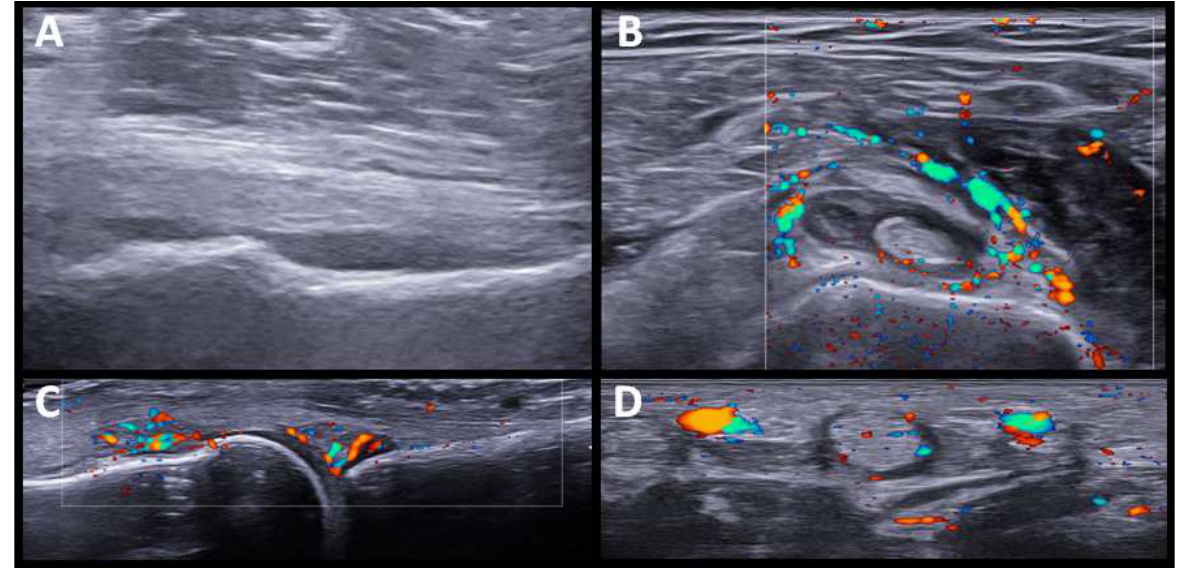
Figure 2. US findings in PMR-like pattern. ( A ). Hip joint (longitudinal view) with moderate effusion. ( B ). Bicipital tenosynovitis with power doppler signal grade 2. ( C ). Synovitis at second MCP joint with Power Doppler grade 2. ( D ). Tenosynovitis of hand flexor tendon with Power Doppler grade 2.